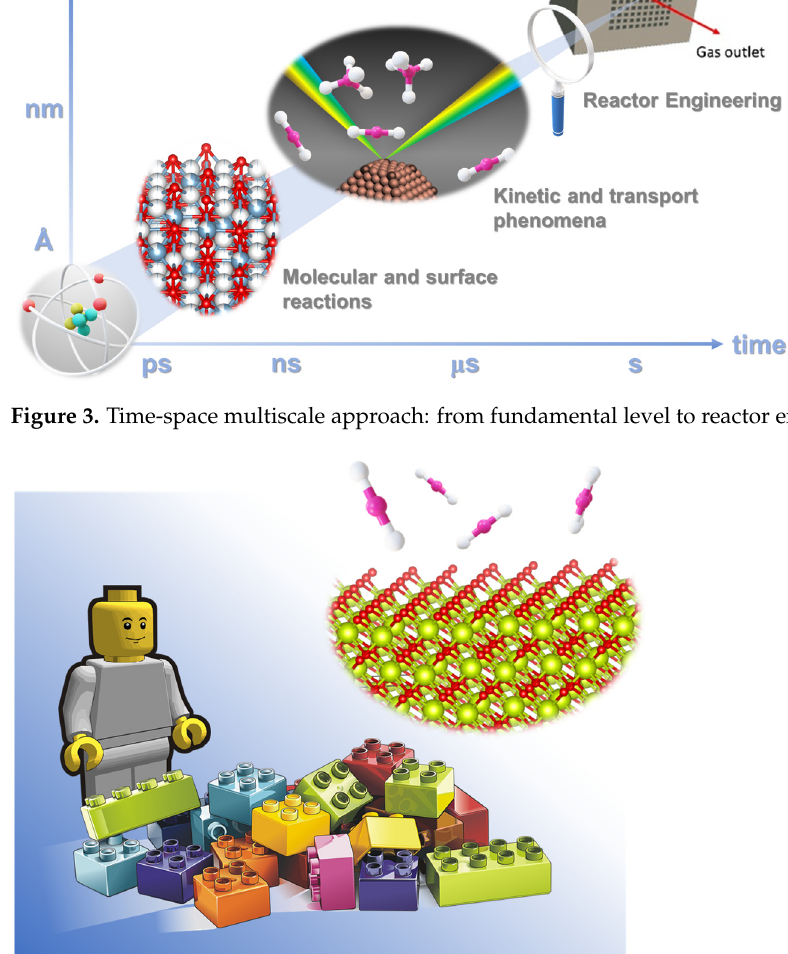
Figure 3. Time-space multiscale approach: from fundamental level to reactor engineering.